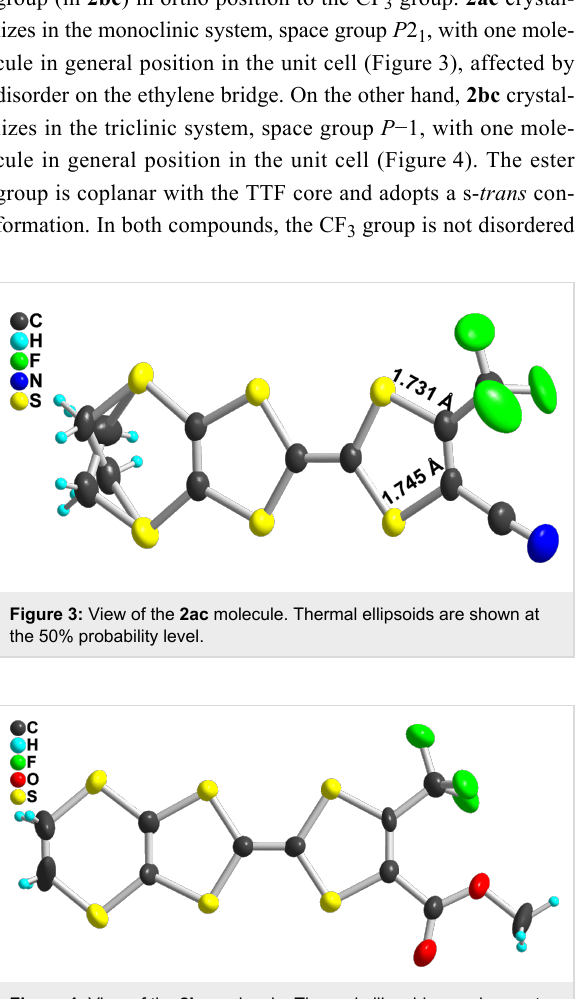
Table 4: Evolution of bonds distances within the dithiole ring in EDT-TTF derivatives substituted with one or two EWG. Definition of the C–S b and b ′ bond distances are given in the scheme below.